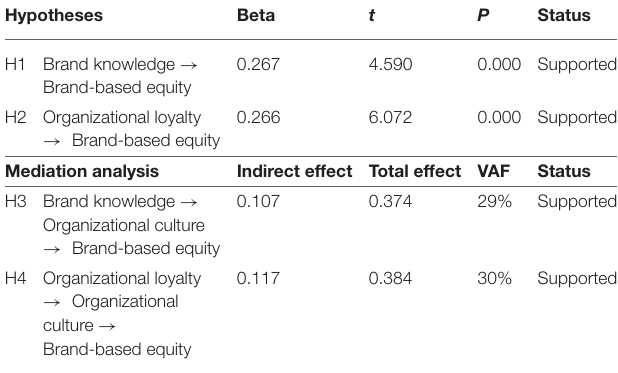
TABLE 5 | F 2 and adjusted- R 2 .